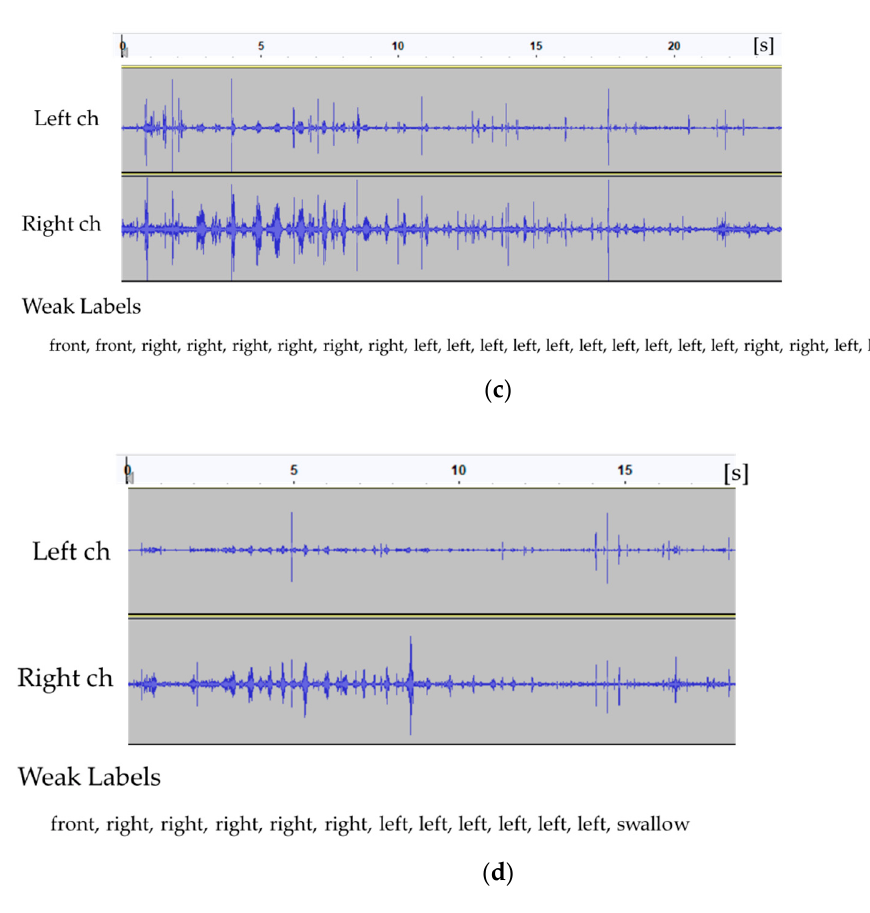
Figure 3. Recorded eating sounds (one cracker) and their corresponding logs for each subject ( a – d